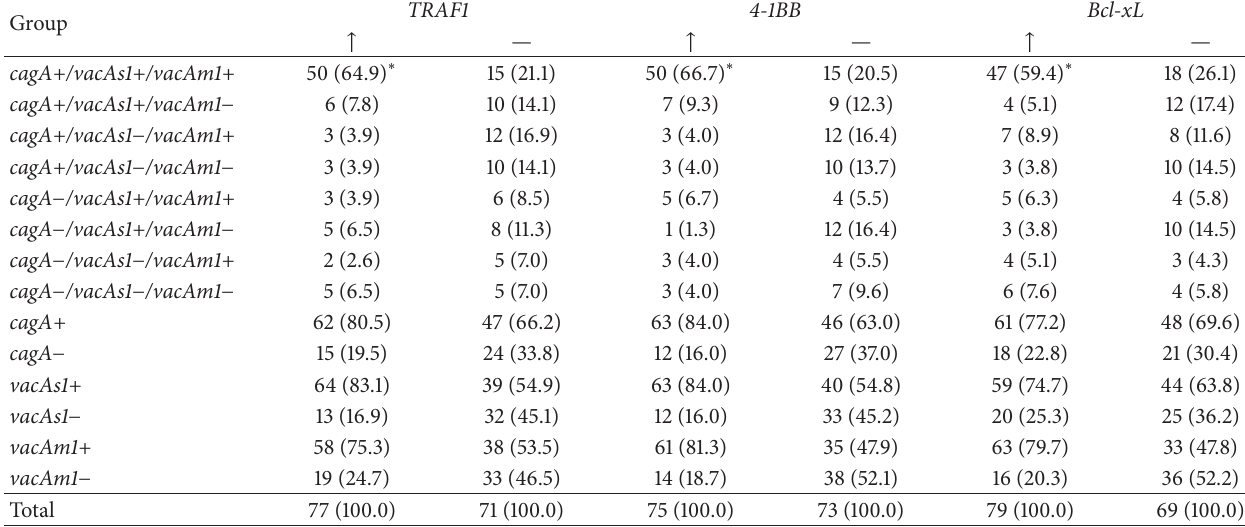
Table 2: Samples positive or negative for cagA, vacAs1, or vacAm1 stratified according to TRAF1, 4-1BB, and Bcl-xL expression. TRAF1 Group